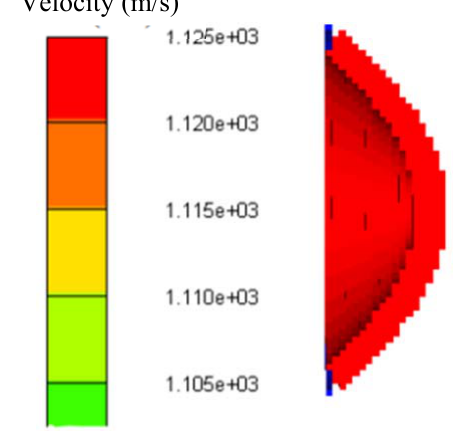
Figure 15. Velocity and shape of tantalum made penetrator (Autodyn); after 100 µs [8] The third material that was used in the simulation is iron, and the main characteristics of iron used in